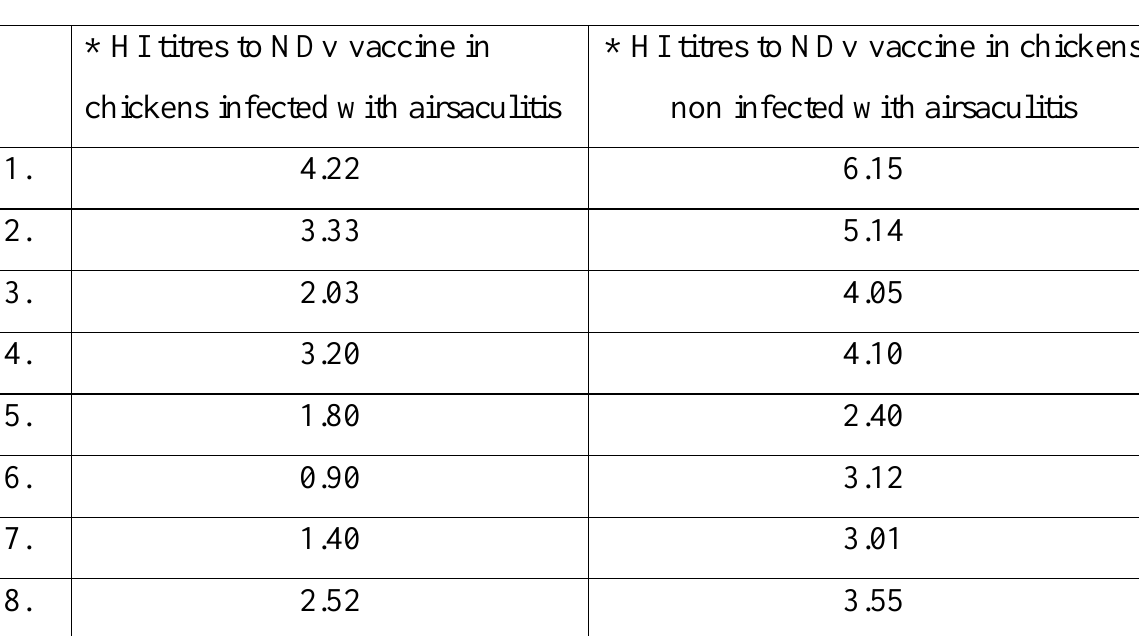
Table (6):- Effect of airsaculitis infection on HI-titres to NDv vaccines in